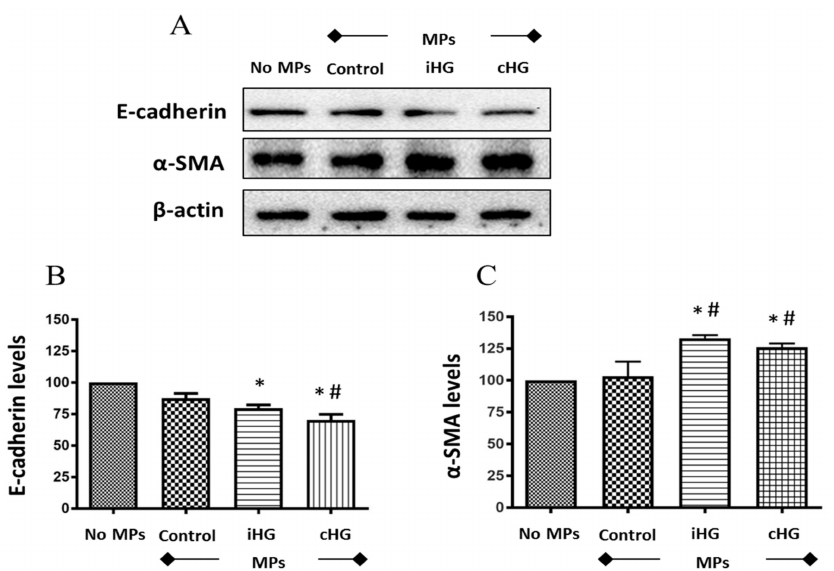
Figure 6. High glucose-derived microparticles (MPs; 10 µ g / mL) induce epithelial-mesenchymal transition (EMT)—demonstrated by a decrease in epithelial-cadherin (E-cadherin) levels and increase in alpha smooth muscle actin ( α -SMA) levels—in naïve renal proximal tubular cells. ( A ) Representative Western blots of EMT markers—E-cadherin and α -SMA; and ( B , C ) densitometry analyses of E-cadherin and α -SMA expression normalized to β -actin, respectively. Values were expressed as mean ± SEM; n = 3; * p < 0.05 versus no MPs (control); # p < 0.05 versus control MPs; E-cadherin: Epithelial-cadherin; α -SMA: Alpha smooth muscle actin; iHG: Intermittent high glucose; cHG: Continuous high